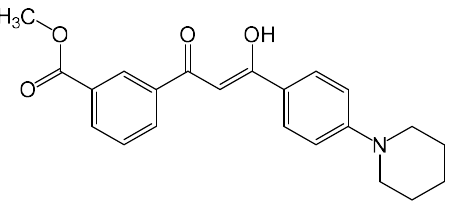
Figure 1. Chemical structure of the title compound.